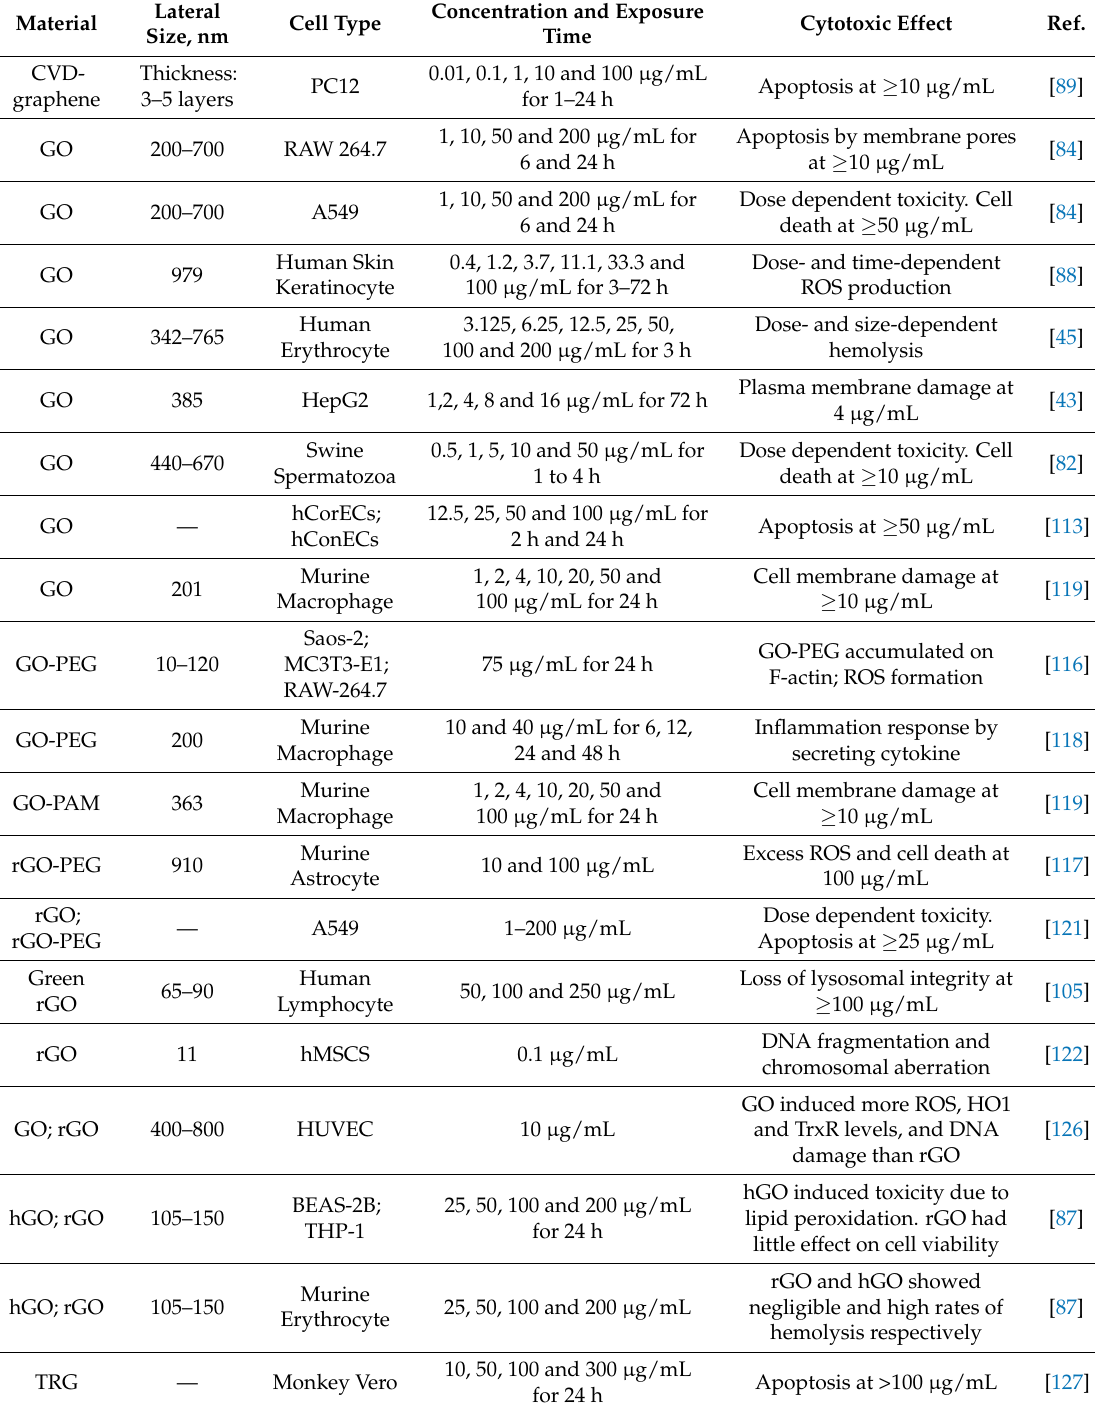
Table 1. In vitro cytotoxicity induced by graphene and its